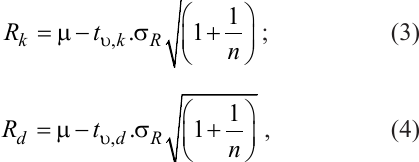
Fig. 3. Failure modes of AC (left) and EP (right)